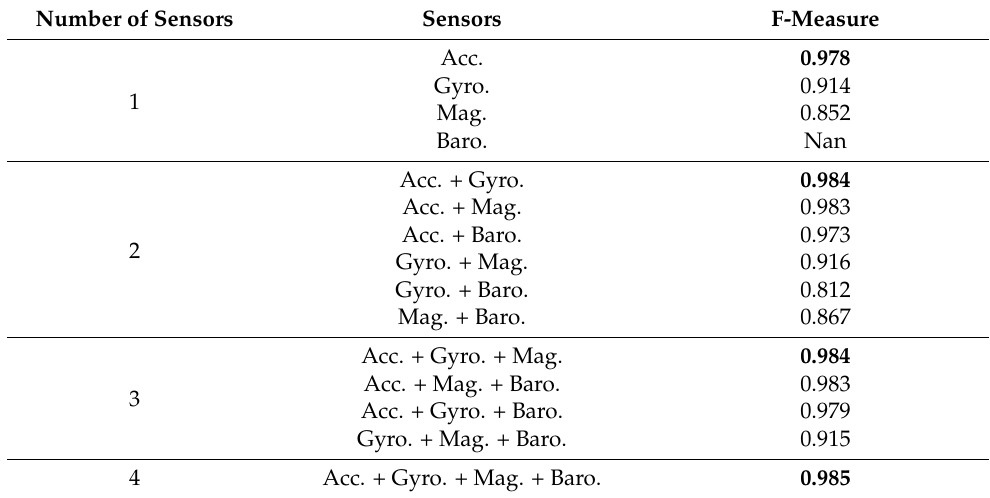
Table 3. Comparisons of different